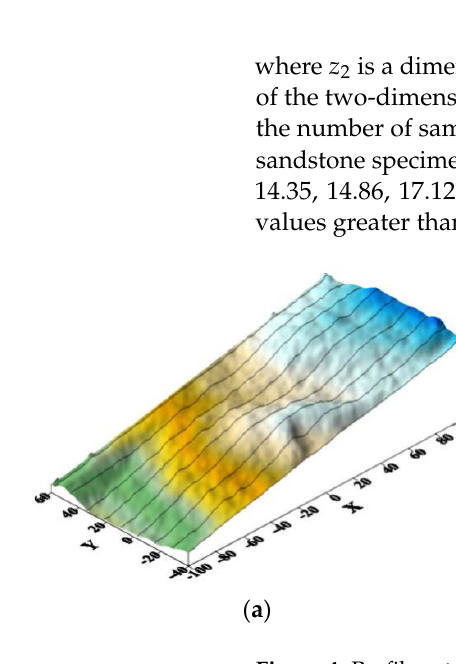
7 of 22 Figure 3. Visualized fracture surface of sandstone sample. The joint roughness coefficient (JRC) proposed by Barton and Choubey [41] is a di- mensionless factor ranging from 0 to 20, which represents the roughness of a rough frac- ture surface [42]. The fracture surface should be first divided into equally-spaced profiles with 5 mm spacing parallel to the direction of fluid seepage, as shown in Figure 4. The fracture surface was divided into nine equally spaced two-dimensional profiles. Secondly, Equation(9a,b) was used to calculate the JRC values of the nine two-dimensional profiles. Finally, the JRC values were obtained by taking the average JRC values of the nine profiles. The JRC values of each two-dimensional profile was calculated according to the following empirical equation [43]: